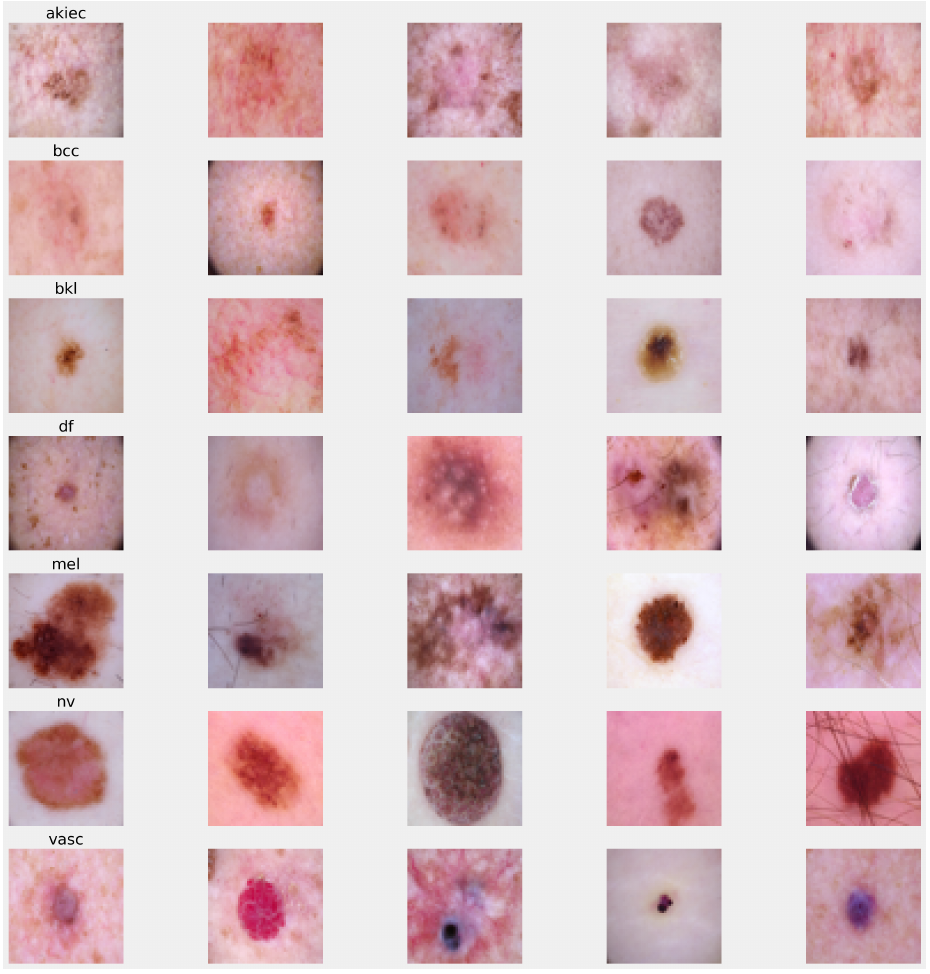
Figure 2. Samples of dermoscopic images along with their